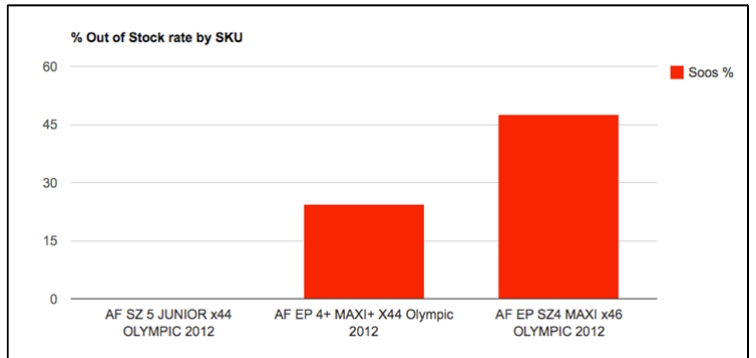
Figure 5. Shelf-out-of-stock rate referring to different